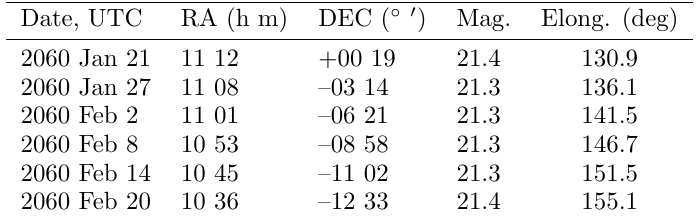
Table 4. Ephemerides of the asteroid 2010 BT3 for its visibility in 2060. The coordinates (J2000) for the Mol˙etai Observatory are